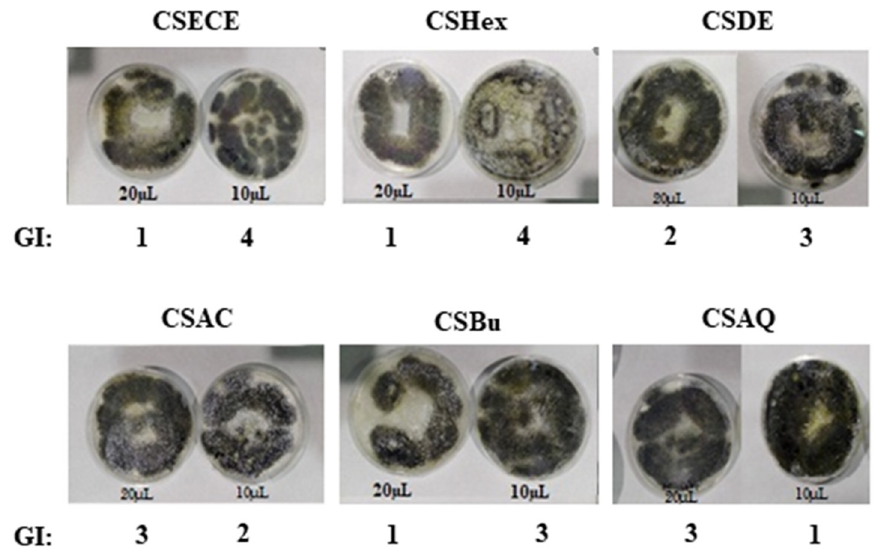
Figure 4. Antifungal activity of the crude extract and the fractions (CSHex, CSDE, CSAC, CSBu, and CSAQ correspond respectively to hexane, diethyl ether, ethyl acetate, n-butanol and aqueous fractions.) against A. niger by the PDA agar method. GI: Growth intensity.